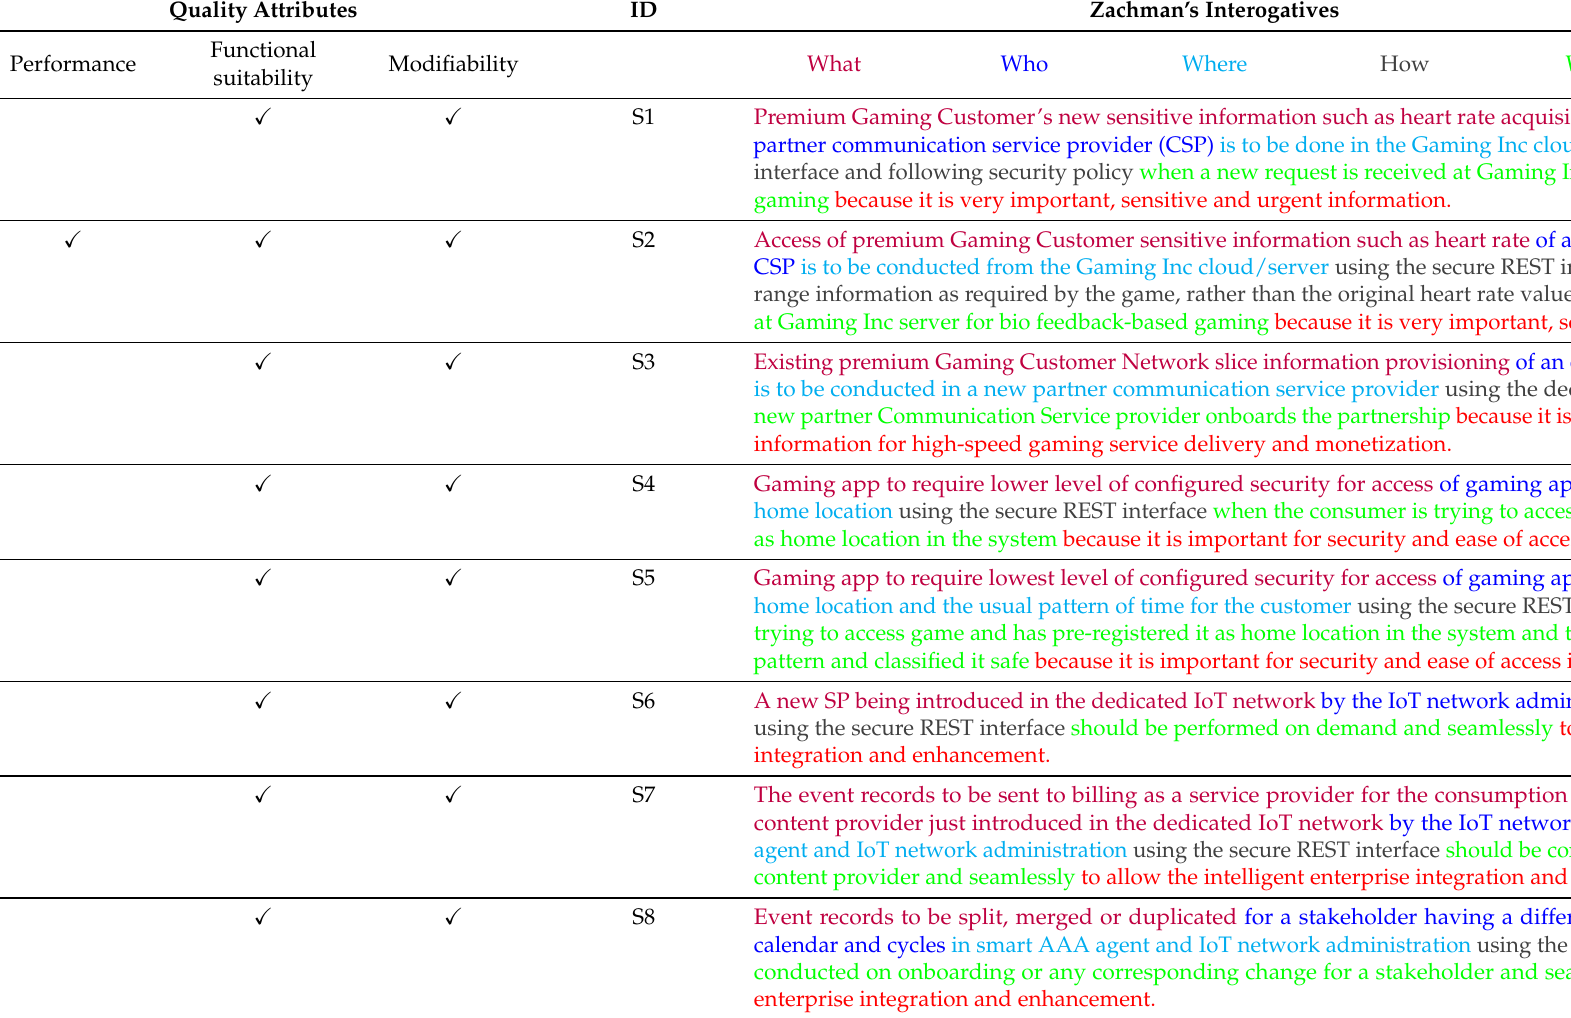
Table 2. Change scenarios for an enterprise gaming IoT network depicted in the Zachman framework model of basic interrogatives. Quality Attributes ID Zachman’s Interogatives Functional Performance Modifiability What Who Where How When suitability